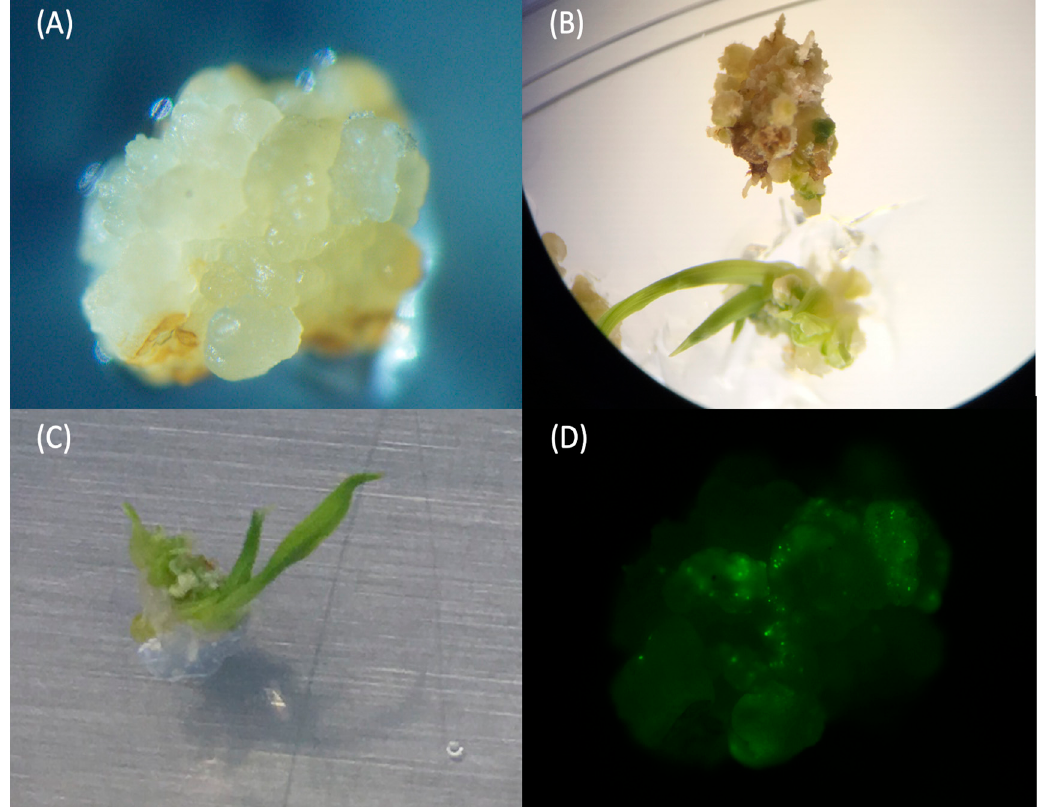
Figure 1. Calli’s performances under a microscope. ( A ) The optimal callus for bombardment. ( B ) Shoot formation of callus on shoot induction medium (SIM). ( C ) Leaf formation of callus on shoot induction medium (SIM). ( D ) YFP fluorescence detection in callus five days after biolistic bombardment pPTN-EYFP vector.